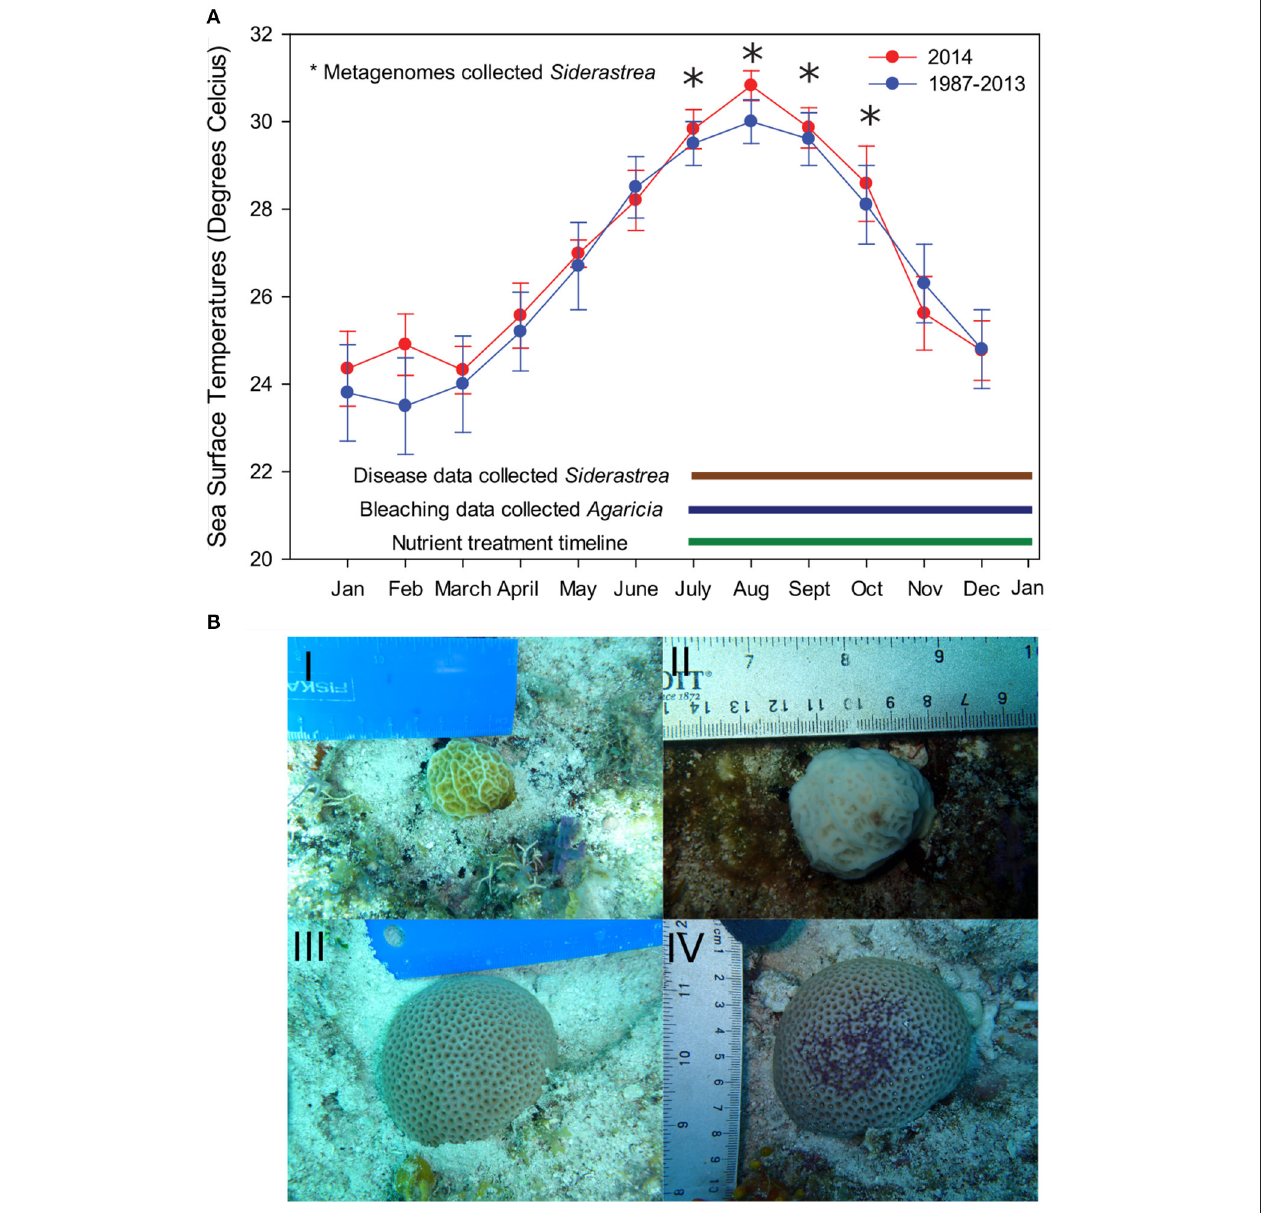
FIGURE 1 | Experimental design and temperature profile from field site. (A) Data from NOAA Molasses buoy show that mean monthly sea surface temperatures in 2014 were significantly elevated both in the winter and summer months (red lines) compared to the monthly means from 1987–2008 (blue lines). Error bars indicate the standard error of means of all temperature data available for that month. (B) During this summer, we monitored control and nutrient exposed Agaricia corals for bleaching prevalence, severity, and recovery as well as tissue loss from July (pretreatment) to January 2015. Photos I and II represent Agaricia corals from July and September, respectively. Siderastrea control and nutrient exposed corals were also monitored for disease prevalence and severity across the course of the experiment. Photos III and IV represent Siderastrea corals from July and September, respectively. Siderastrea mucus samples for metagenomes (indicated by the stars) were only collected at the pretreatment time point (July 14, 2014) and three post treatment months: August 13th, Sept 14, and October 14th.